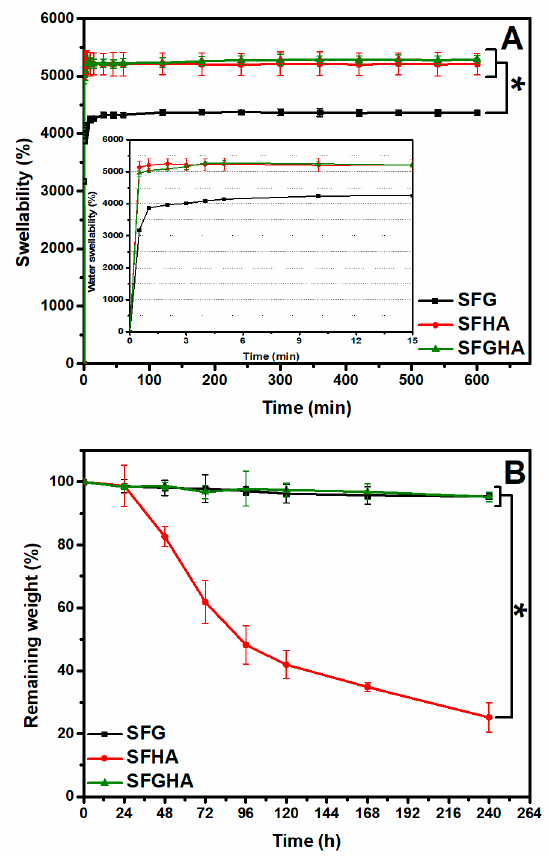
Figure 2. Physical properties of the crosslinked SFG, SFHA, and SFGHA scaffolds. ( A ) Swellability of the scaffolds after immersion in PBS at 37 °C. An inset presents the data in the first 15 min. ( B ) Remaining weight of the scaffolds after the incubation in cell culture medium at 37 °C. The asterisk (*) indicates the statistical difference at a p -value ≤ 0.05.